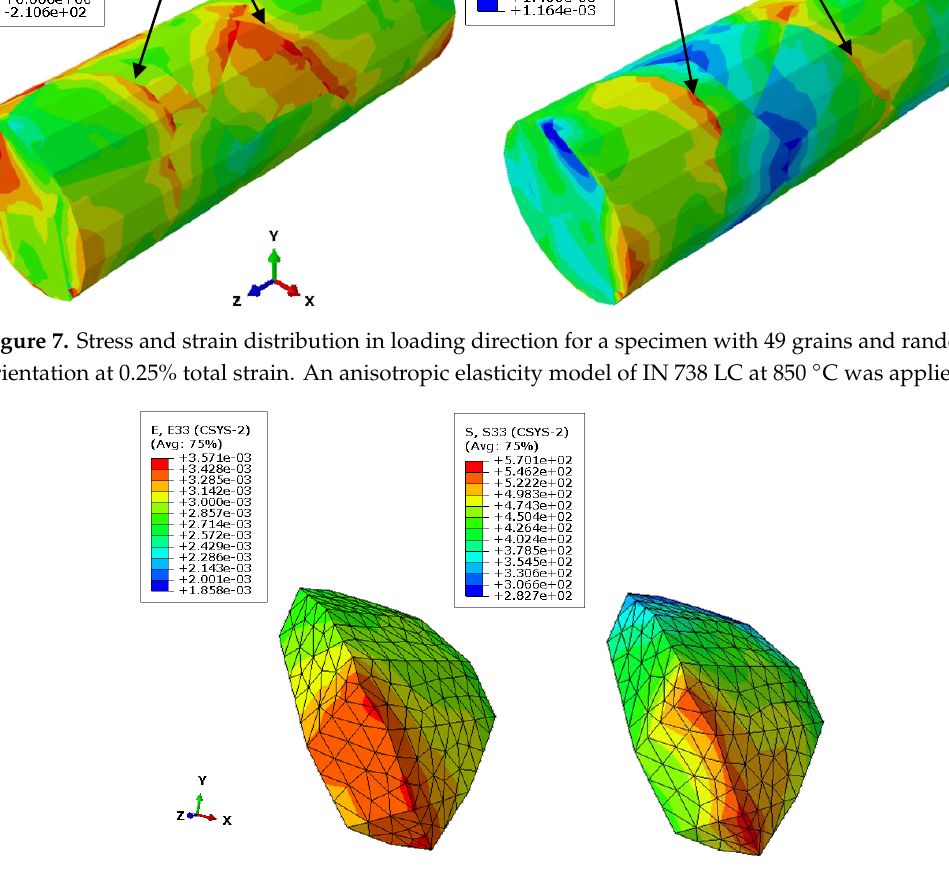
Figure 8. Stress and strain distribution in loading direction of a free cut grain from the specimen model with 49 grains at 0.25% total strain and 850 °C.